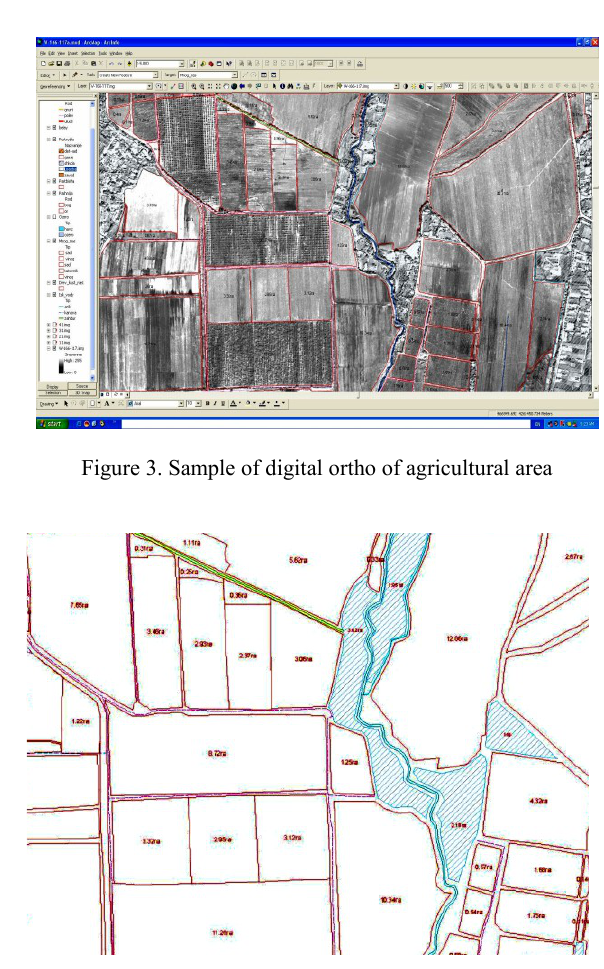
Figure 4. Sample of cadastral map elaborated in